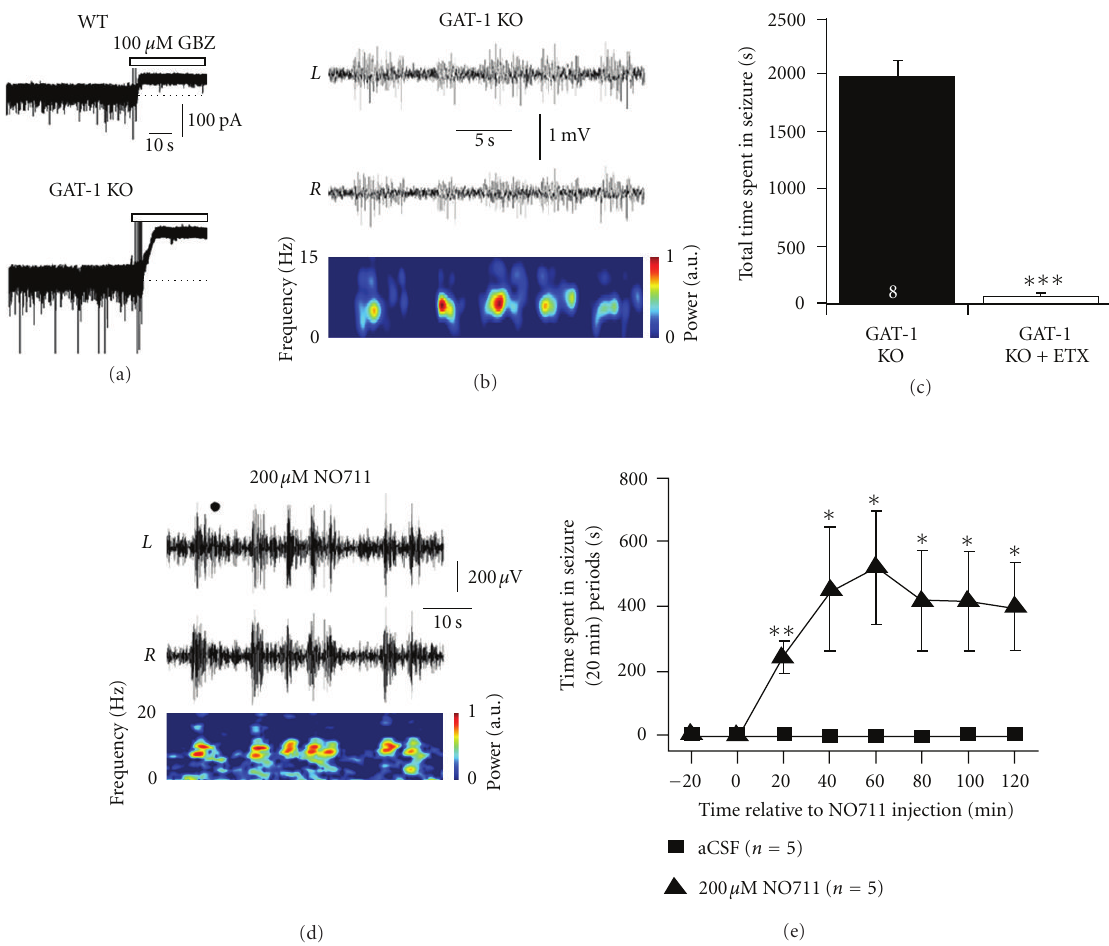
Figure 4: Loss of functional GAT-1 in TC neurons leads to SWDs. (a) In adult (P68-74) GAT-1 − / − mice, tonic GABA A currents in VB TC neurons are significantly larger than in WT littermates. (b) Simultaneous bilateral EEG traces reveal that adult GAT-1 − / − mice also display SWDs (WT animals did not display SWDs—data not shown). The spectrogram at the bottom corresponds to the EEG signal from the right (R) hemisphere. (c) Treatment of GAT-1 − / − mice with the anti-absence drug ethosuximide (200mg per kg body weight i.p.) significantly reduces the total time spent in seizures. (d) Bilateral EEG traces from a normal Wistar rat following intrathalamic administration by reverse microdialysis of 200 μ M of the selective GAT-1 blocker NO711 (spectrogram of the L trace is illustrated below). (e) Time course of the induction of SWDs by intrathalamic administration of NO711. (a–e) reproduced from